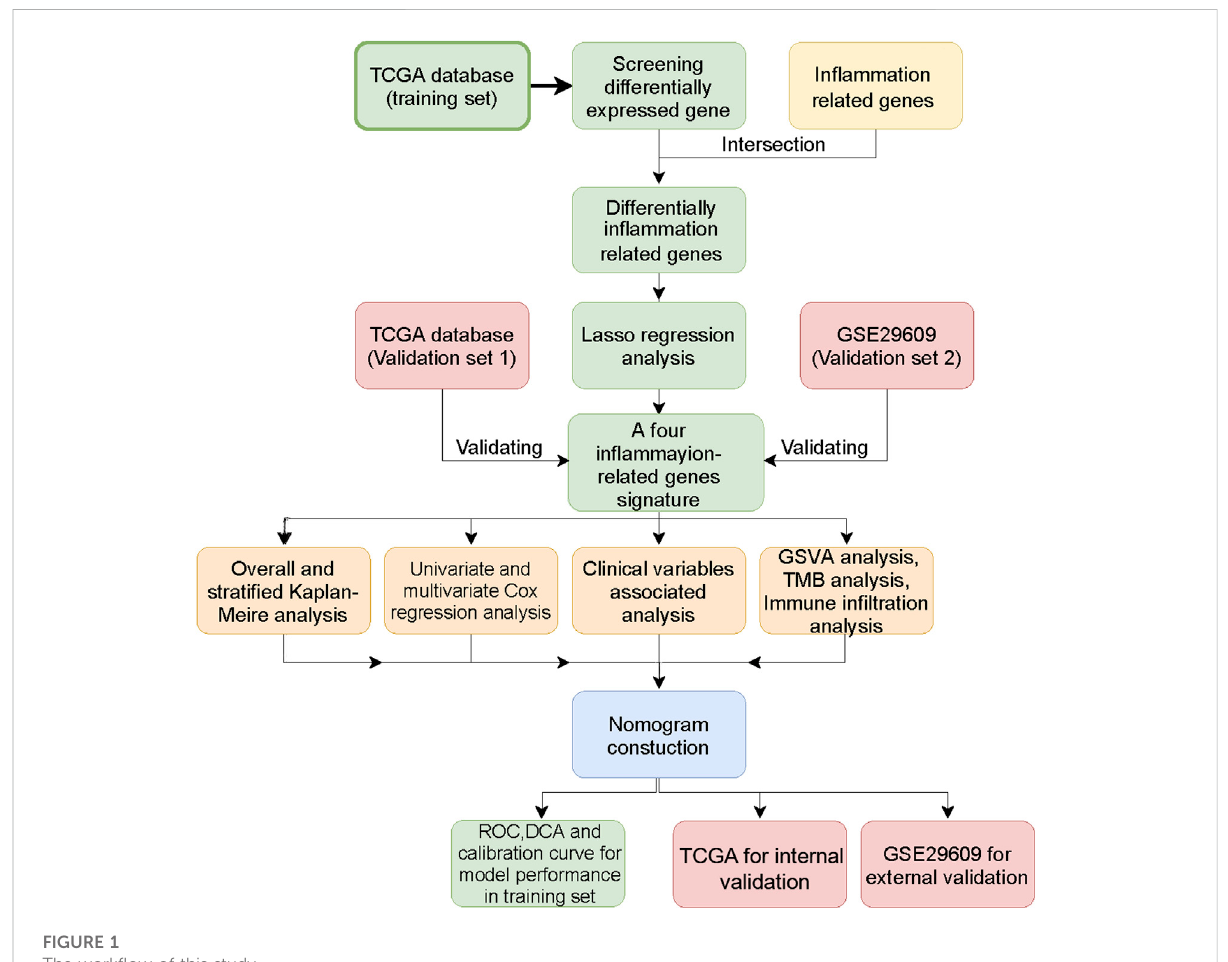
FIGURE 1 The work fl ow of this